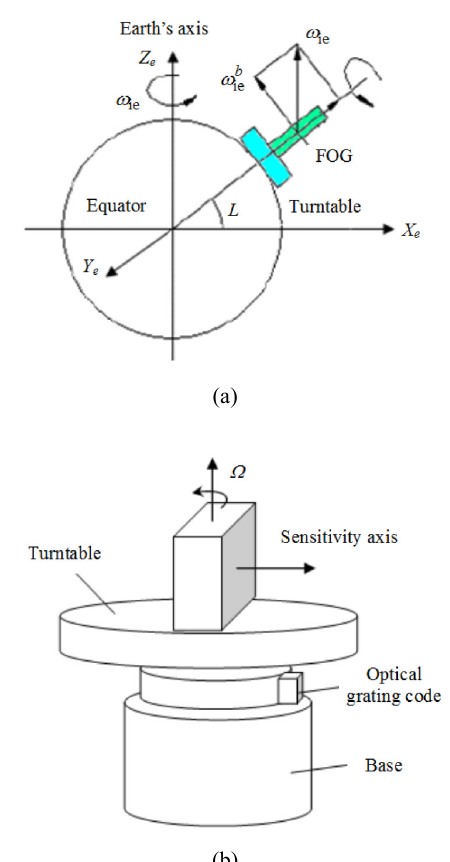
Fig. 1 Fiber optic gyro and its dynamic north-seeking principle: (a) principle of the fiber-optic gyro north-finding and (b) principle of the fiber optical gyro dynamic north seeker